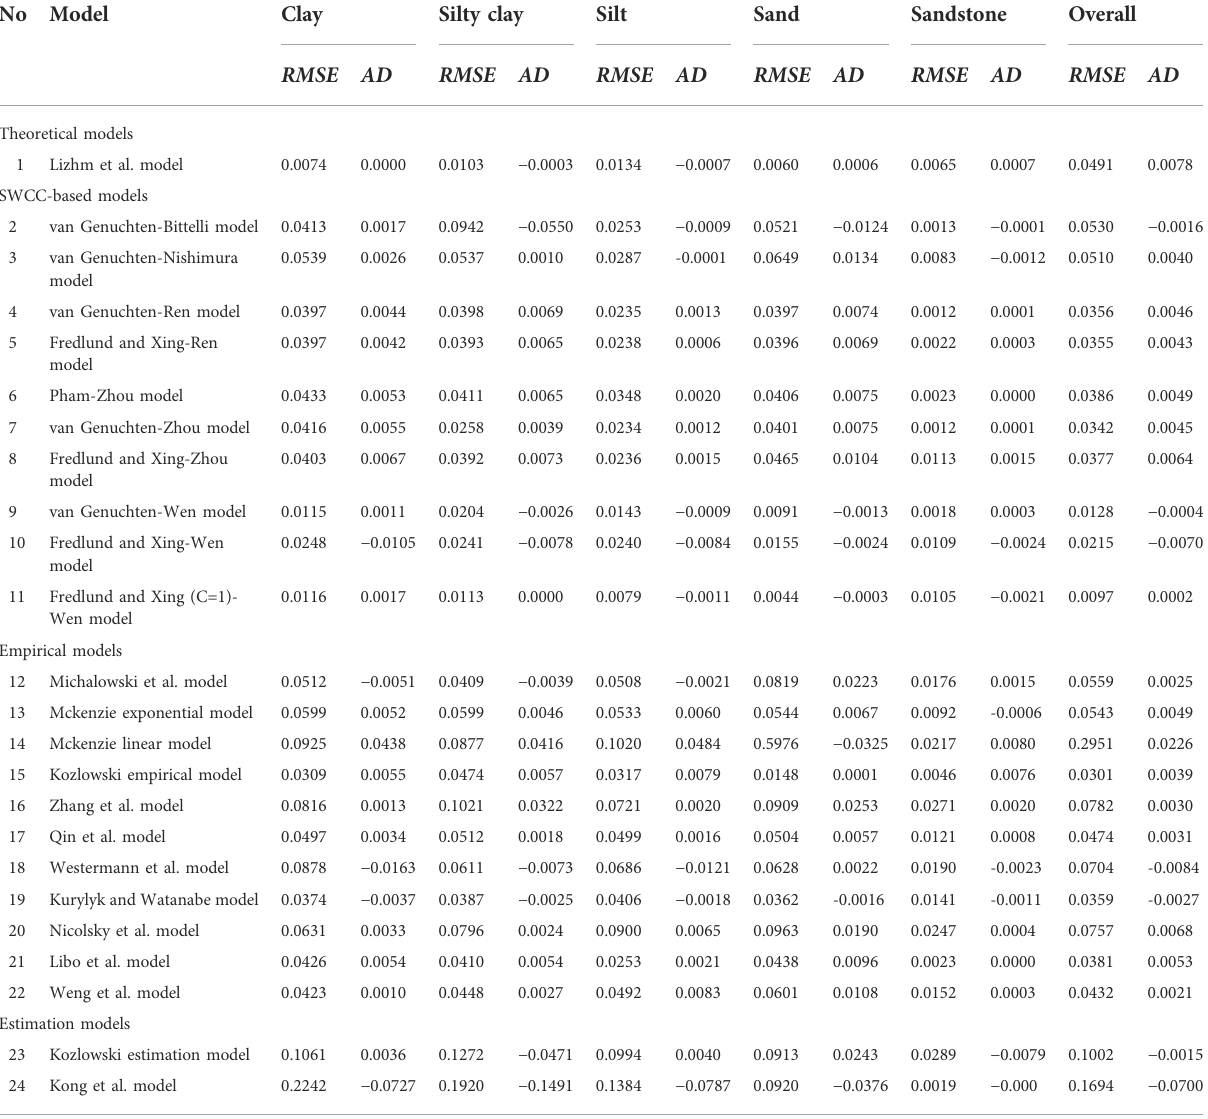
TABLE 3 Performance of the selected unfrozen water content